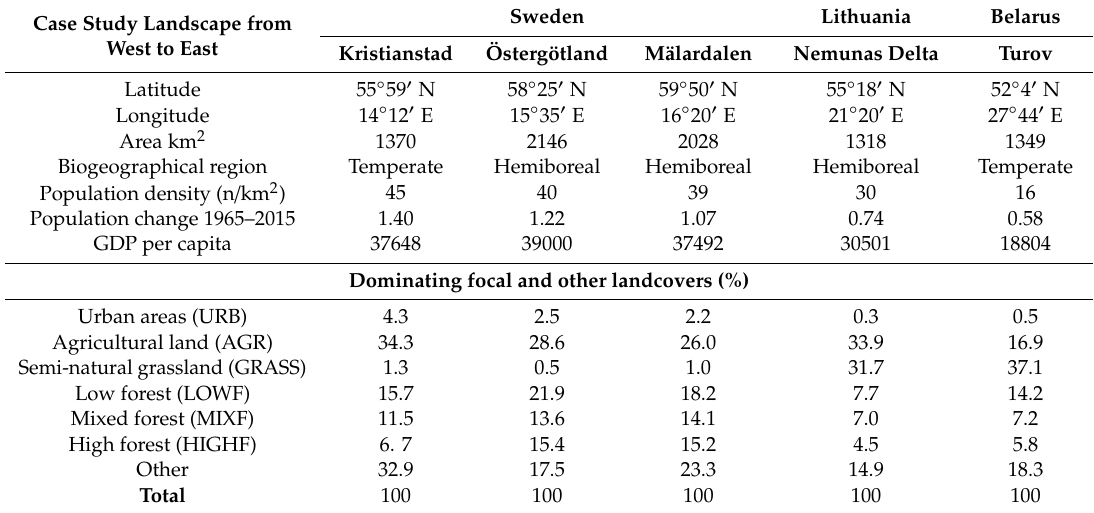
Table 1. Description of the five landscape case studies in the Baltic Sea Region’s West-East gradient (see Figure